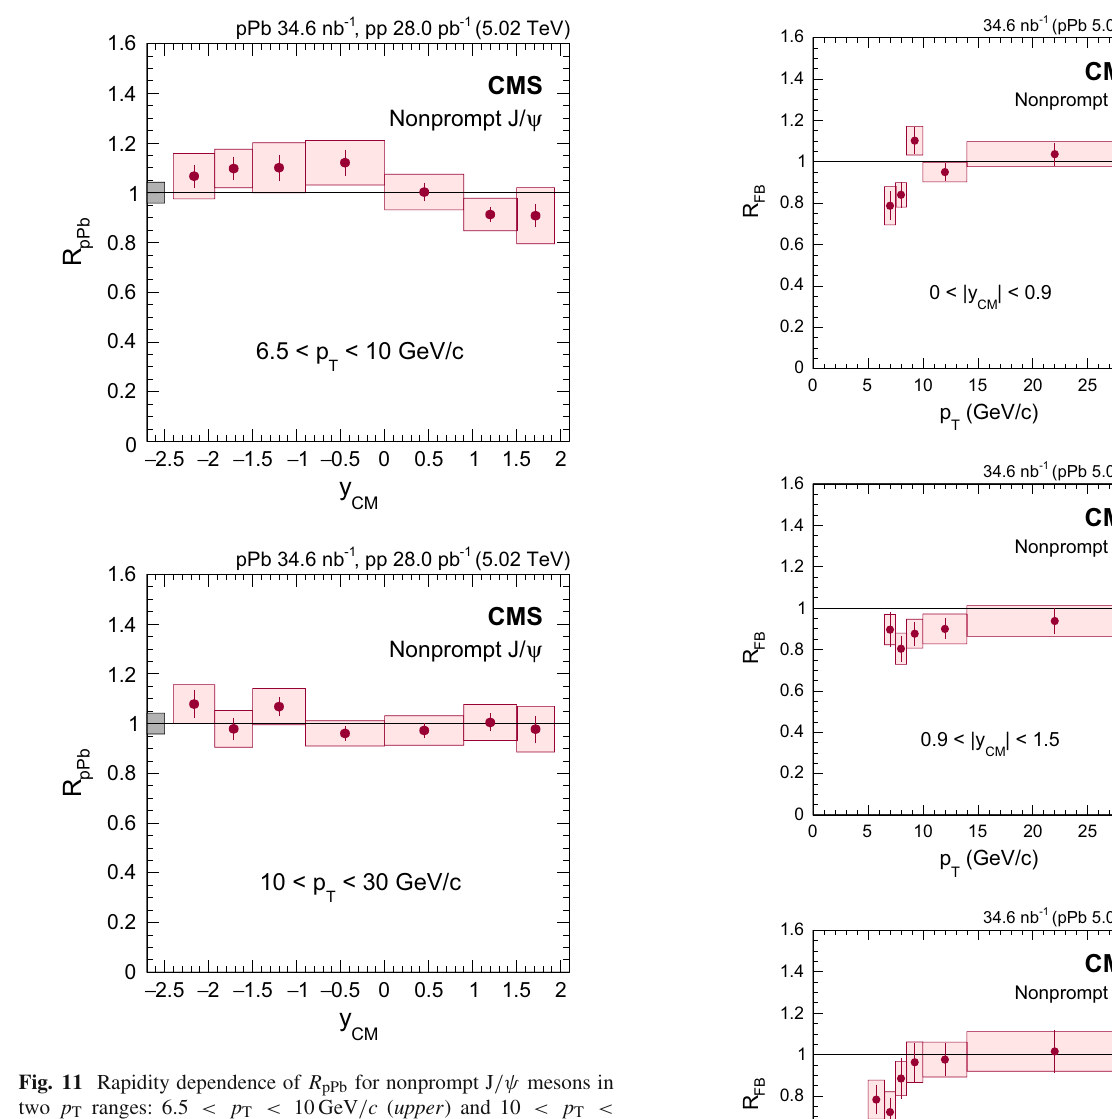
y CM > 1 . 5 and p T (cid:2) 7 . 5 GeV / c , but not at larger p T , con-